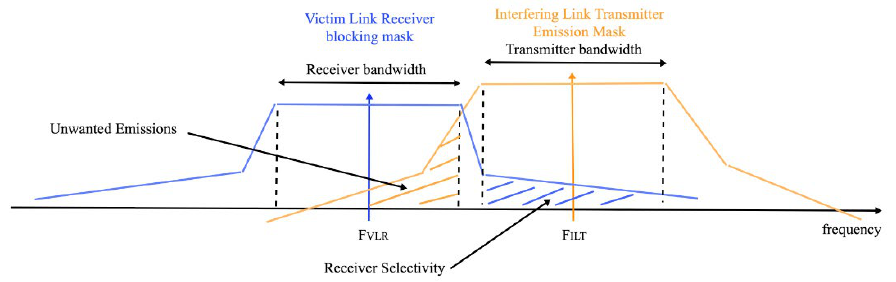
Figure 3. Unwanted emissions and receiver